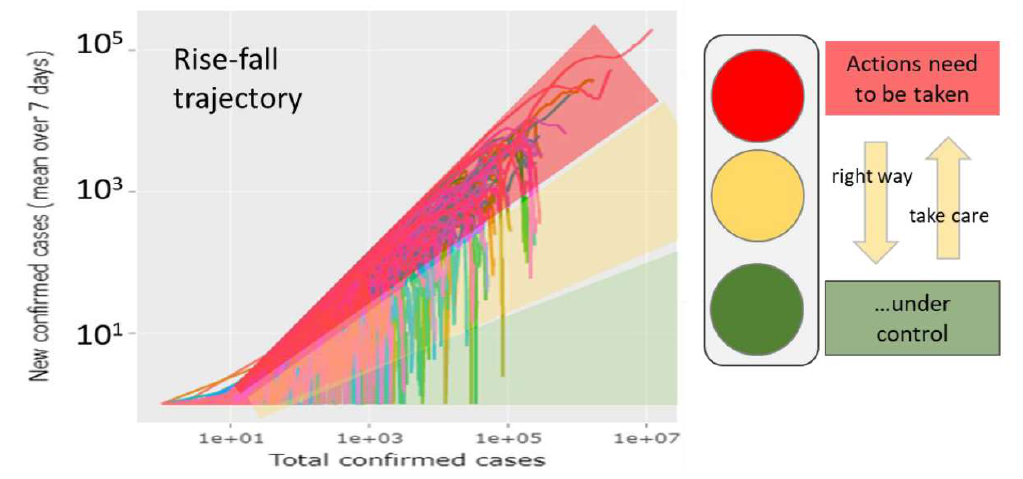
Figure 11. Traffic light dashboard for evaluating the state of the epidemic. The rise-fall trajectories provide the ‘phase-space’ of pandemic roughly dividing countries into ones that need to take actions, countries where epidemic is under control and countries that are at the right way if trajectory is falling or that have to take care if trajectory is rising (see also Figure S6).